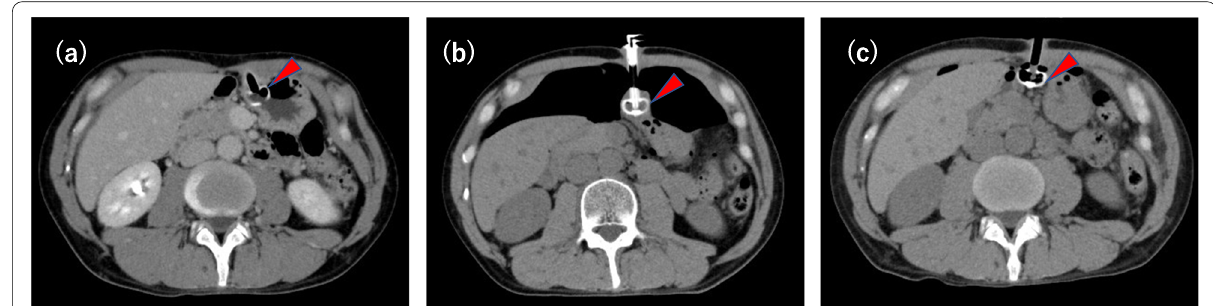
Fig. 1 Computed tomographic images. Preoperative computed tomographic scans ( a ) showed percutaneous endoscopic gastrostomy bumper (red arrow) fixing stomach properly. Postoperative computed tomographic scans ( b ) showed percutaneous endoscopic gastrostomy bumper (red arrow) dislodged from abdominal wall. Postoperative day 4 computed tomographic scans ( c ) showed percutaneous endoscopic gastrostomy